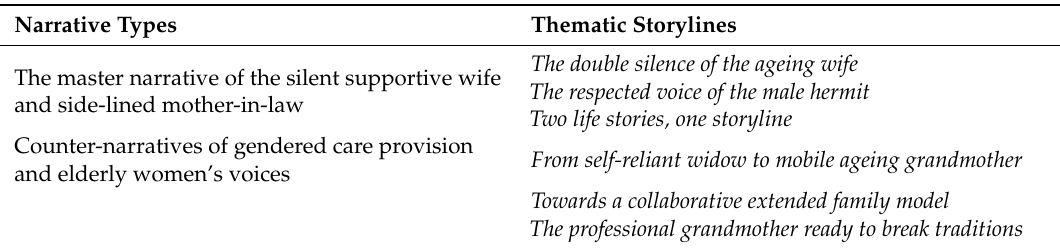
Table 2. Master and counter-narratives and belonging